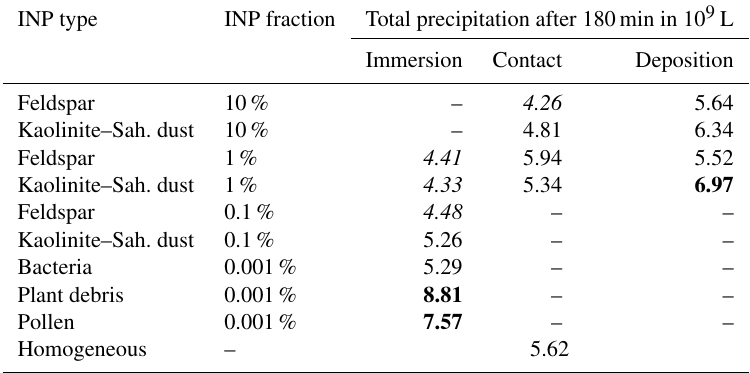
Table 3. Total precipitation after 180min of modeling time for coupled homogeneous and one heterogeneous freezing process. Marked in bold: cases with more than 20% enhancement of precipitation. Marked in italics: cases with more than 20% reduction of